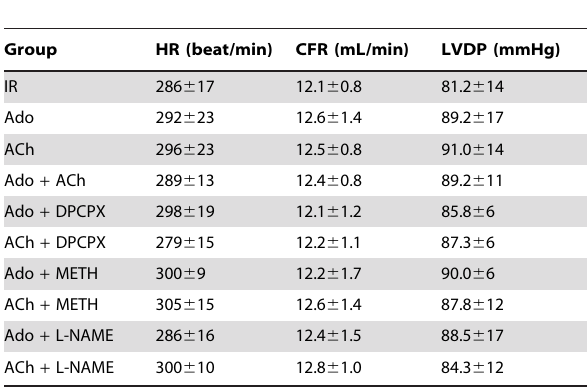
Table 1. Baseline cardiodynamic data after 30 min of equilibration to Langendorff